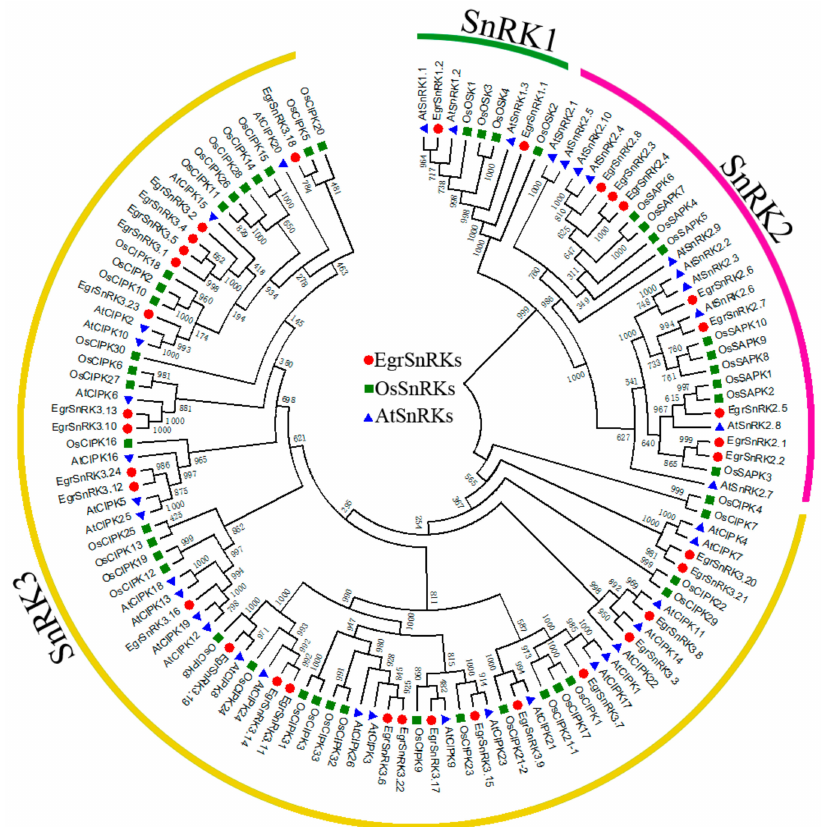
Figure 1. Phylogenetic tree of SnRK genes from Eucalyptus grandis, Arabidopsis, and rice. Thirty-four E grSnRK genes, 39 AtSnRK genes, and 48 OsSnRK genes are clustered into three subgroups (SnRK1, SnRK2 and SnRK3). The SnRK genes from E. grandis , A. thaliana , and rice are denoted by red, blue, and green, respectively. Details of the SnRK genes from all three plant species are listed in Table S2. The tree was generated using Clustal X 2.0 software using the neighbor-joining (N-J)